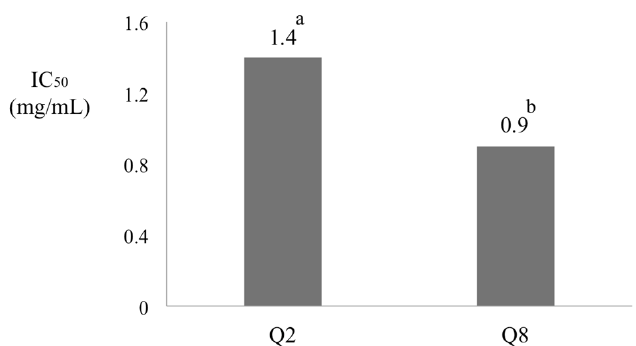
Figure 4. Comparison of DPPH (1,1-diphenyl-2-picrylhydrazyl) radical scavenging activity between Q2 and Q8 (IC 50 ). Values are means ± standard error (SE) ( n = 3). Means that do not share a letter are significantly different ( p = 0.05).